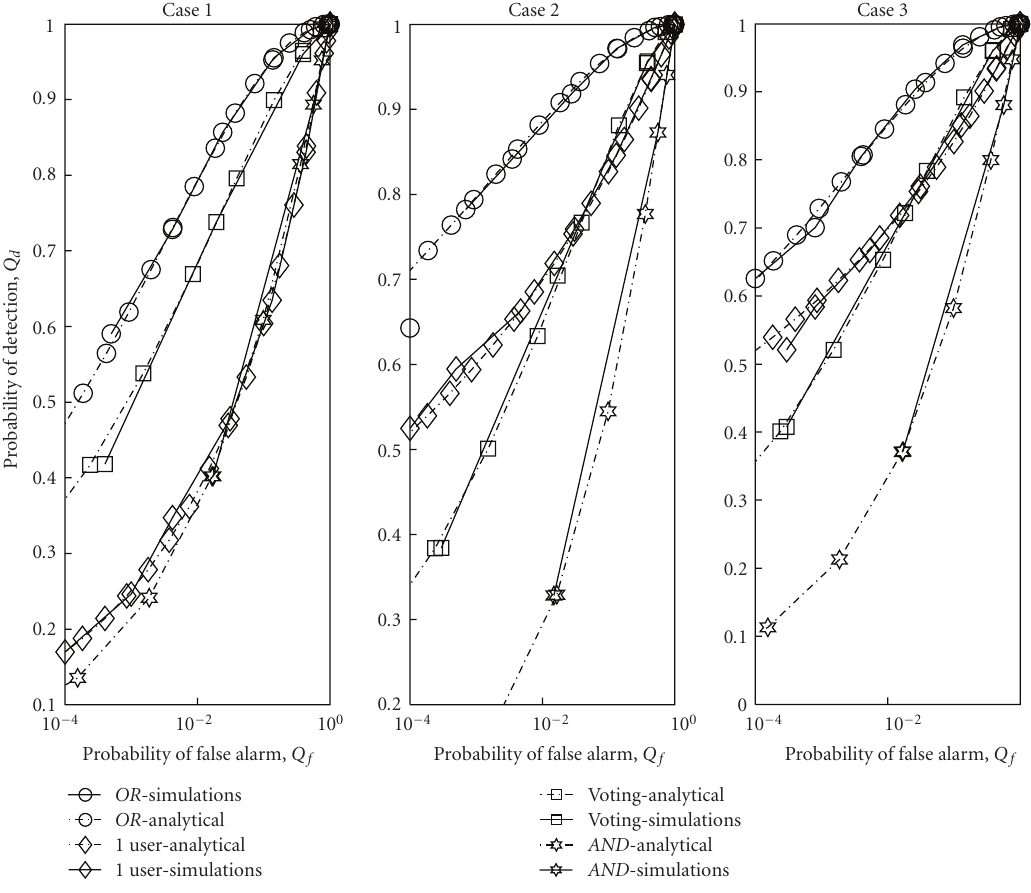
Figure 8: Receiver operating characteristics for 5 collaborating users in Rayleigh fading Channel in 3 cases: Case 1 (all users have similar SNR), Case 2 (half of the users have high SNR), and Case 3 (only one user has high